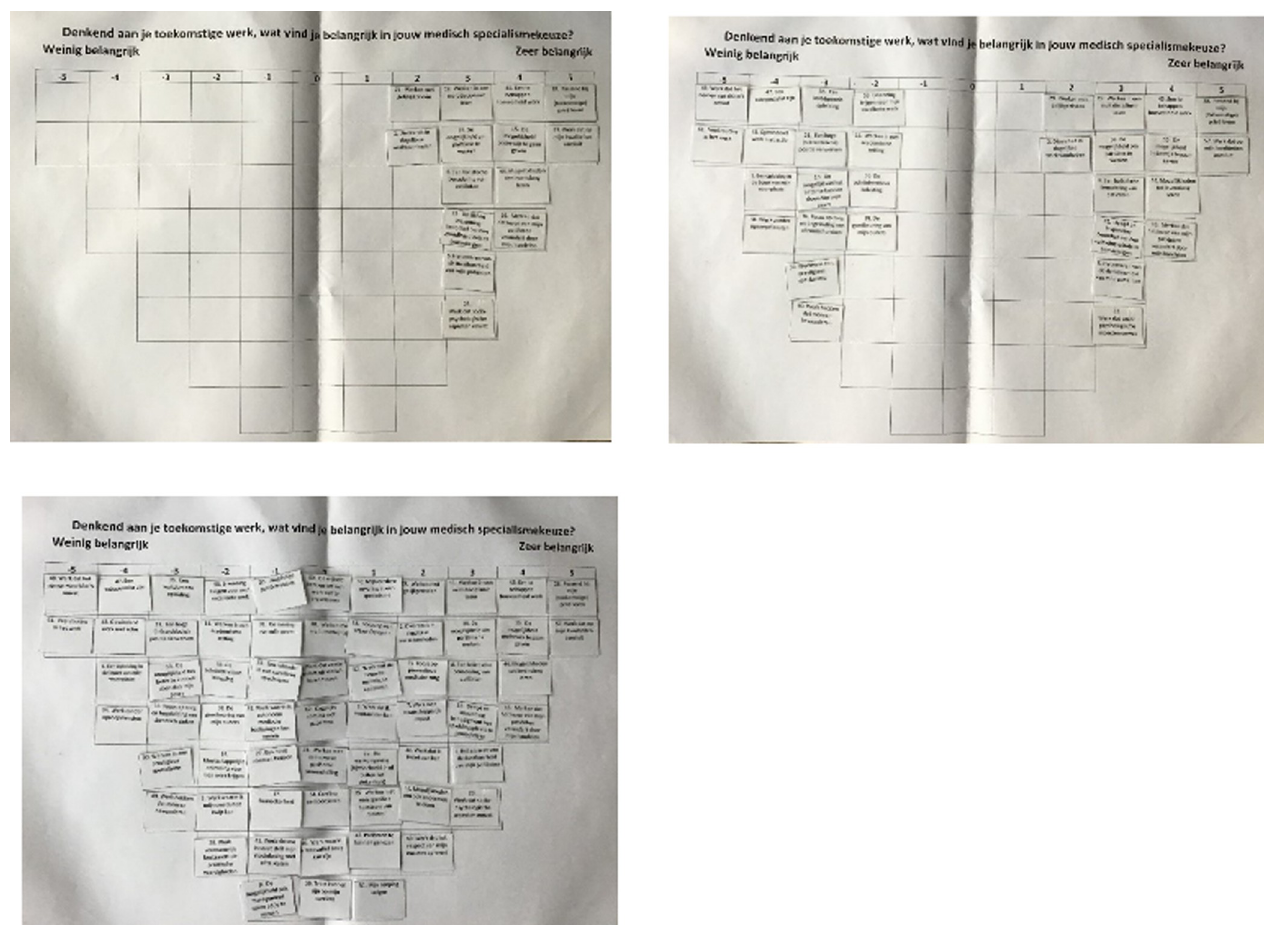
Fig 2. Step-wise representation of the sorting